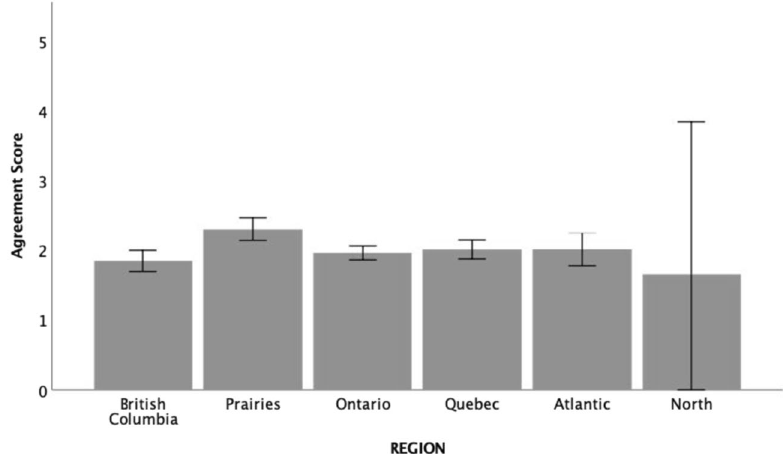
Fig. 5 Consumer support for ban on all single-use plastics used for food packaging by region. Error bars indicate standard